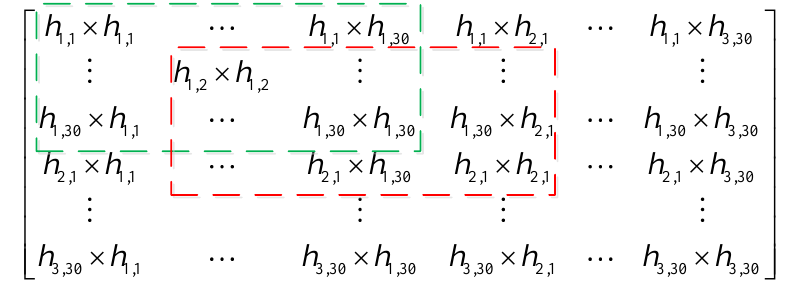
Figure 4. Process of 2D-SS on R X .